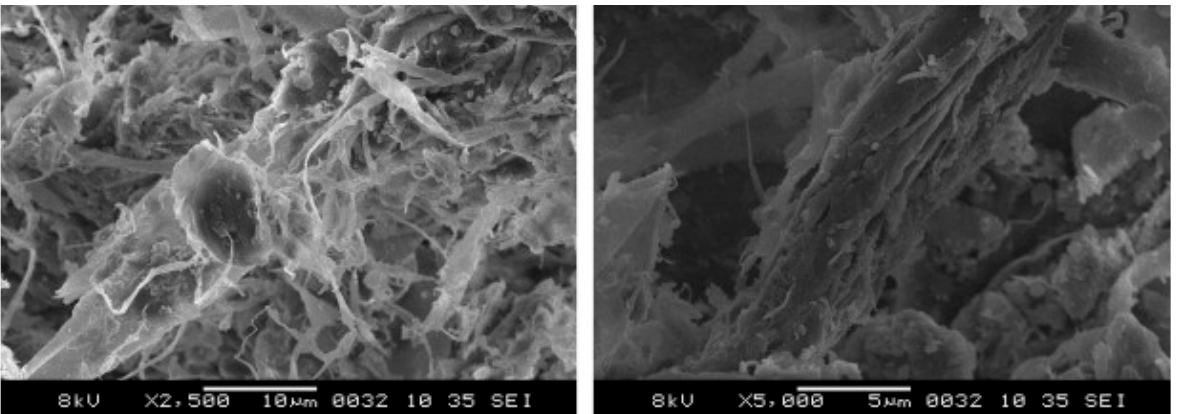
Figure 2. Microscopic view of raw waste paper used by Raut et al. [21] and Rajput et al. [20] for concrete brick production.